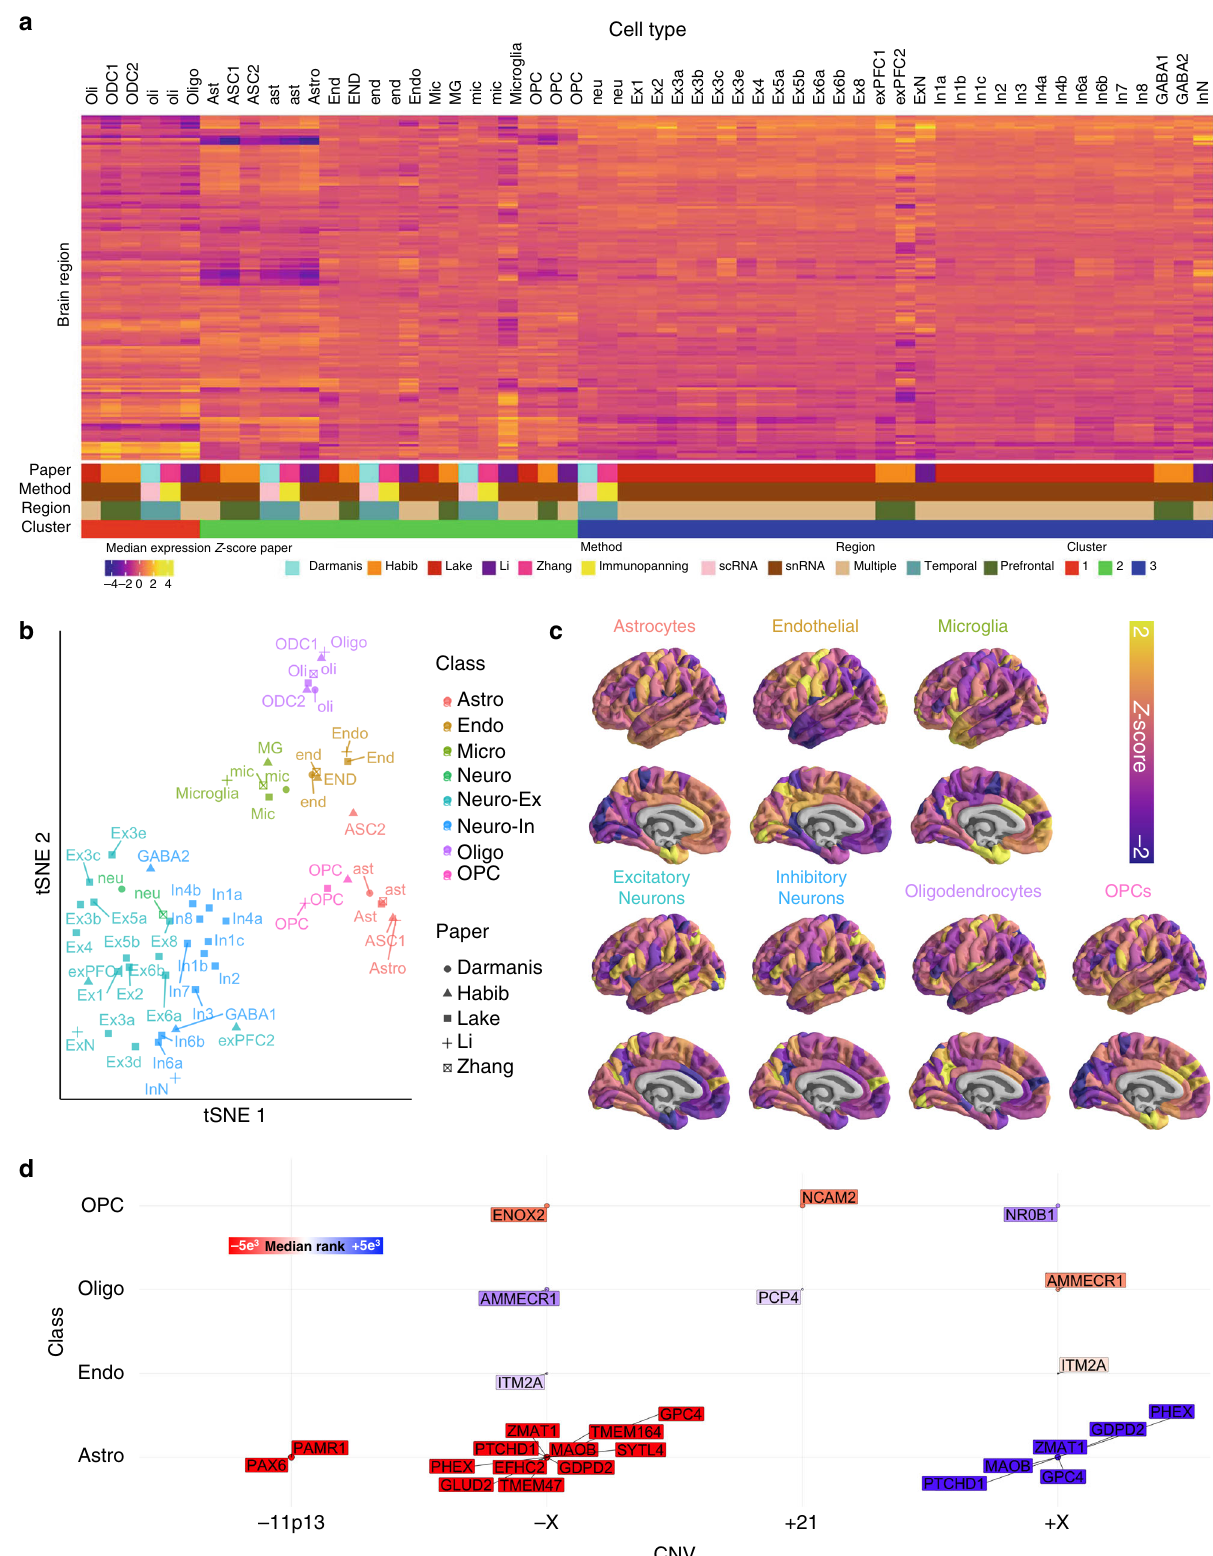
to cortical changes in + 21 and + X = indicating that they are most highly expressed in cortical regions of MS increase in patients vs. controls (e.g., + 21: insula and cingulate cortex, + X: precuneus, lateral temporal lobe), and that they are least